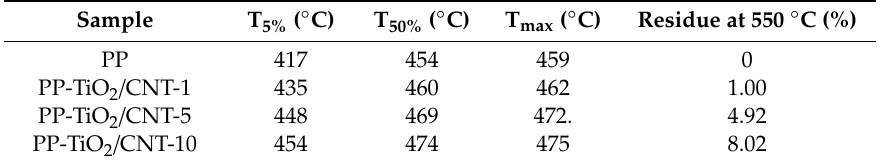
Table 3. Thermal properties of nanocomposite of polypropylene-carbon-nanotubes (PP-TiO 2 /CNT).